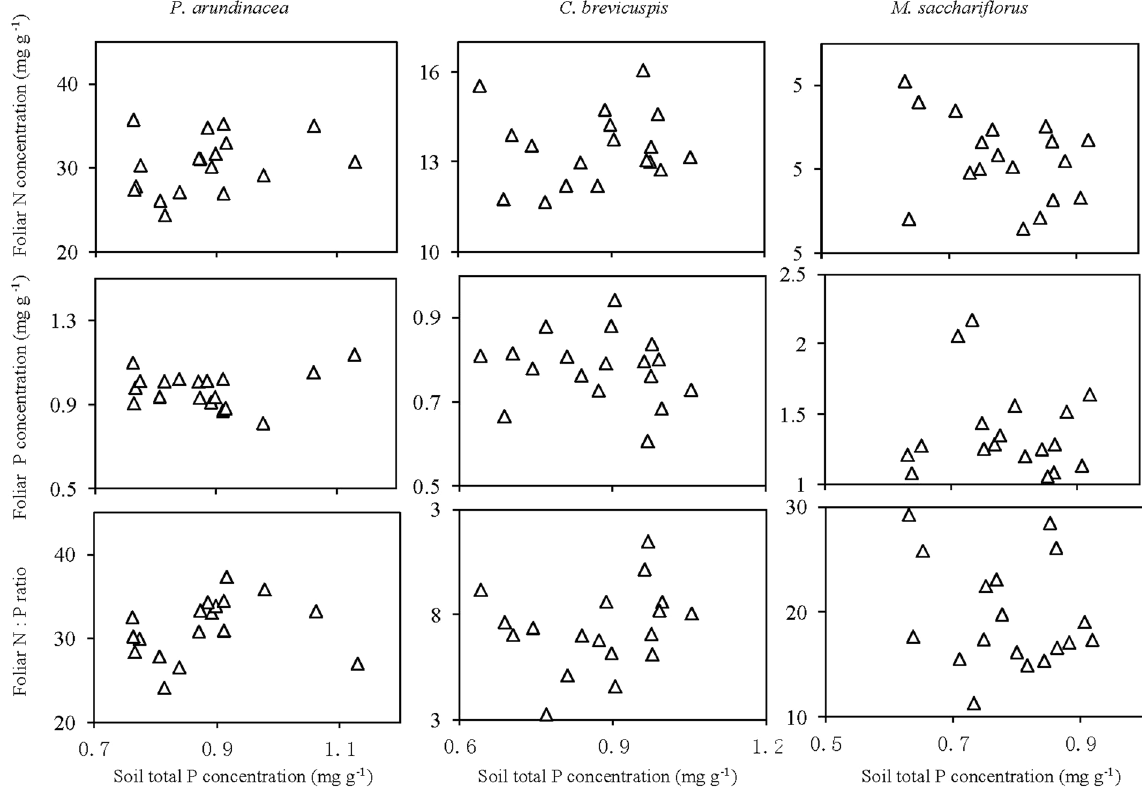
Figure 5. Relationship of foliar stoichiometric indexes with soil phosphorus (P) of the 3 wetland species distributed along an elevation gradient in 3 lakeshore areas of Dongting Lake,